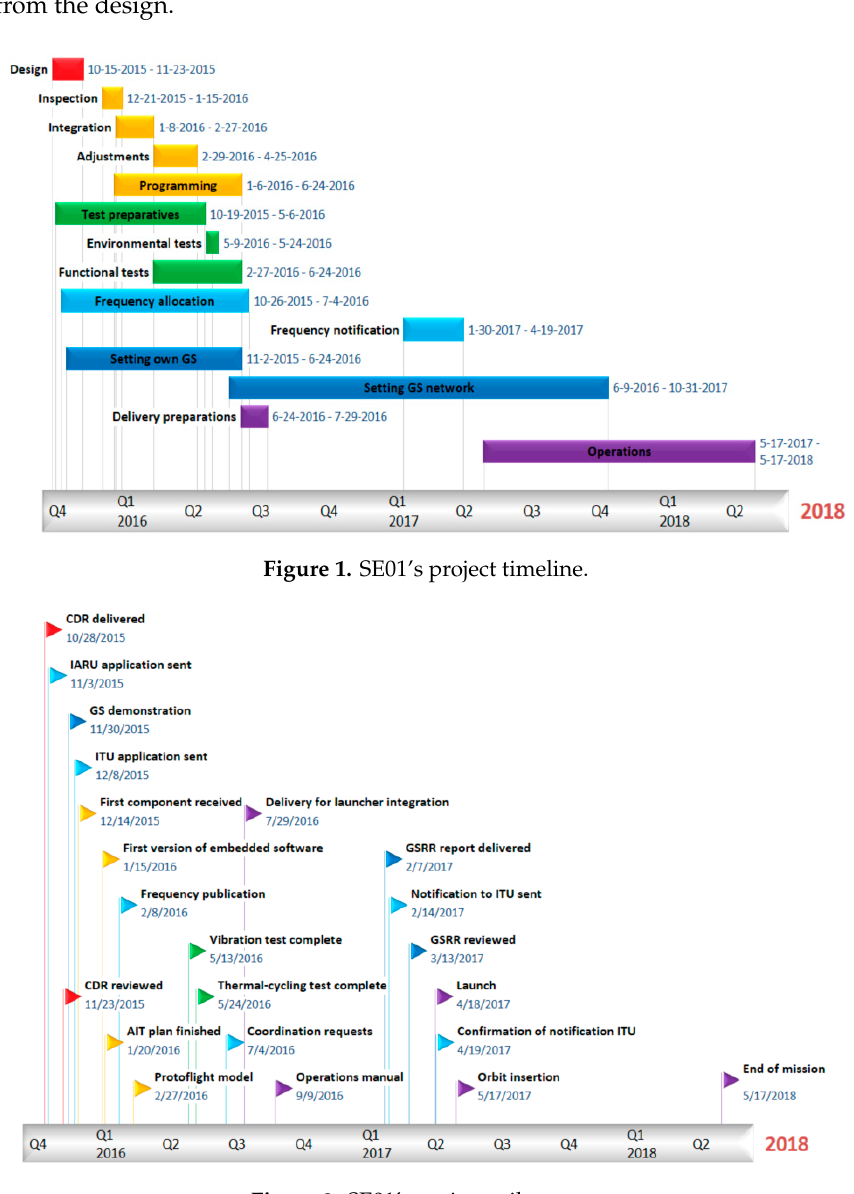
Figure 2. SE01’s project Figure 2. SE01 ′ s project milestones. Figure 2. SE01 ′ s project milestones.